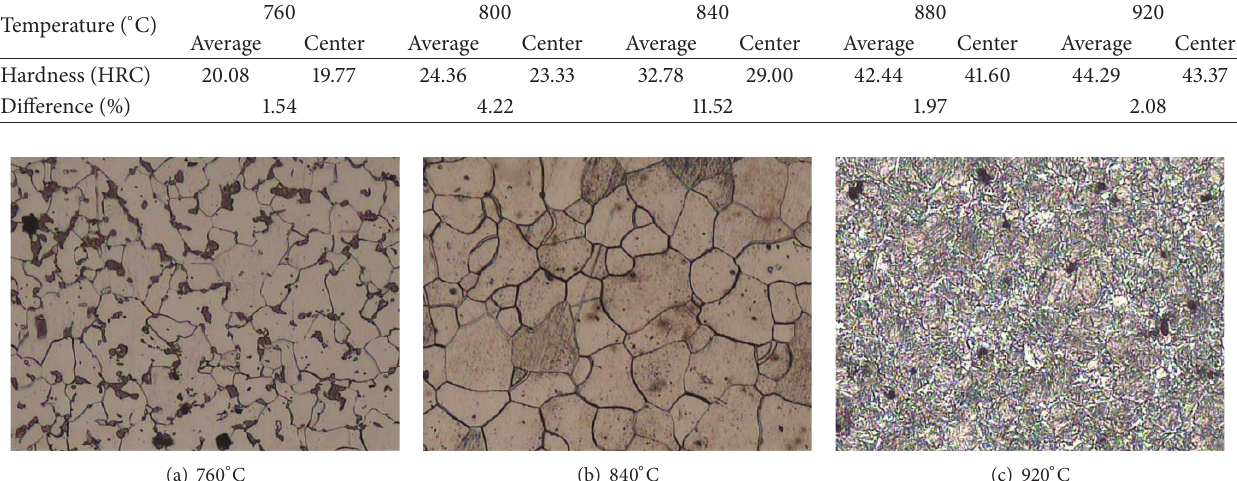
Table 1: Hardness along the circle of 1/2 radius and center of the samples with different temperatures.